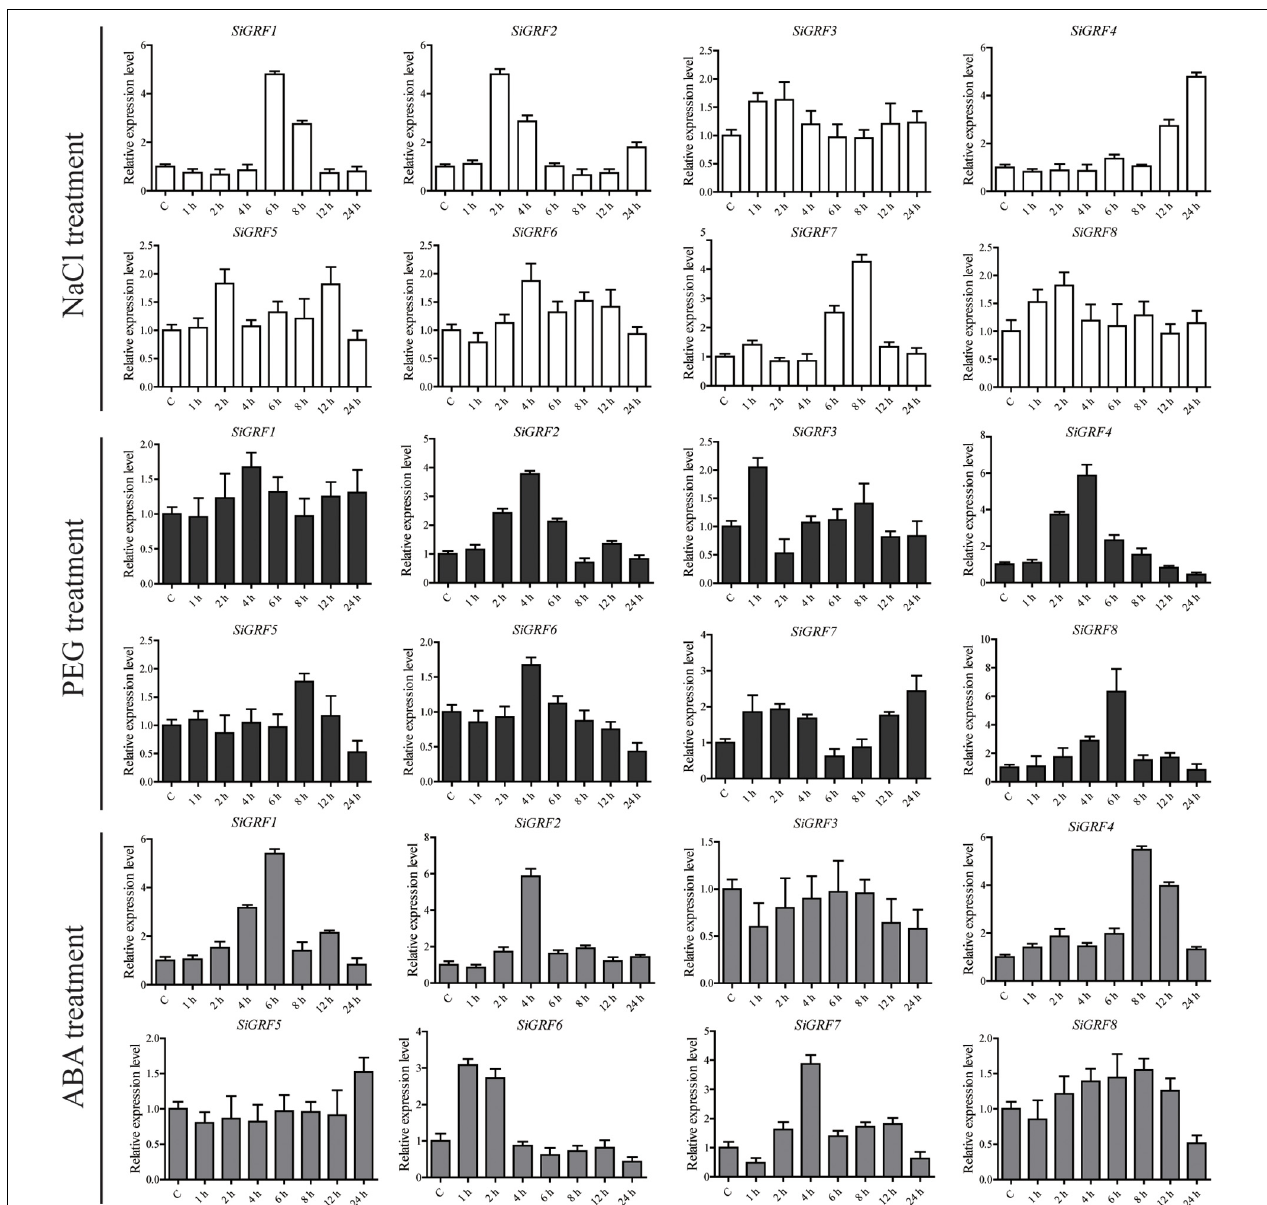
FIGURE 4 | Relative expression levels of SiGRF genes analyzed using qPCR under treatment of salinity stress, 6% PEG, or ABA for 1, 2, 4, 6, 8, 12, or 24 h. The relative expression level of each gene was calculated relative to the expression in the respective untreated control samples (0 h). Foxtail millet SiActin (Si036655m) was used as an internal control to normalize the expression data. The error bars represent the standard deviation calculated based on three biological